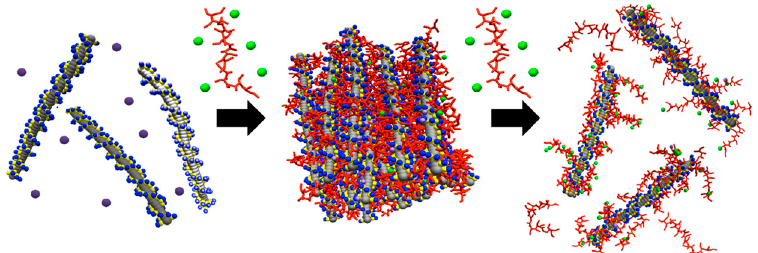
Figure 5. Reversible condensation and decondensation of DNA by varying the protamine-to-DNA